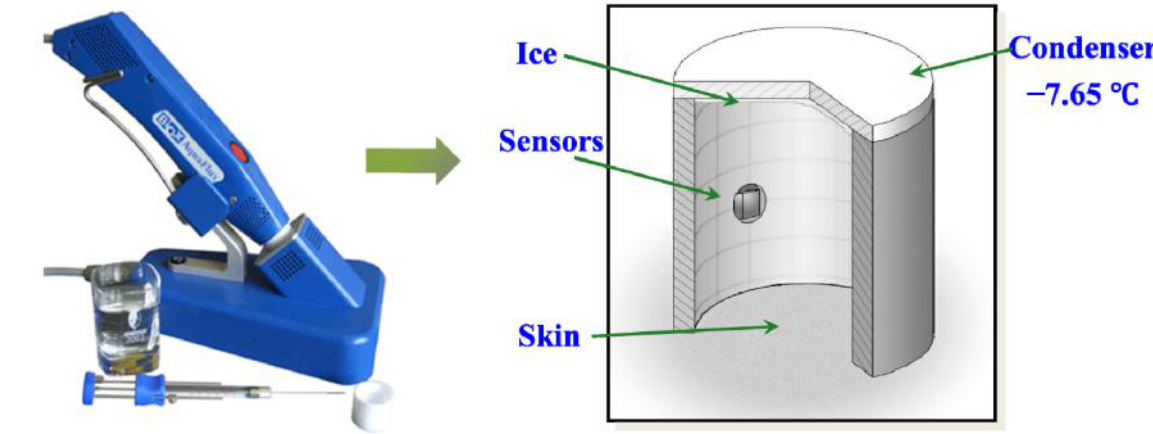
Figure 3. AquaFlux evaporimeter and its measurement principle. The chamber visible on the right is housed within the tip of the AquaFlux evaporimeter and contains the humidity sensors that detect the TEWL. Image reproduced with permissions from [47].